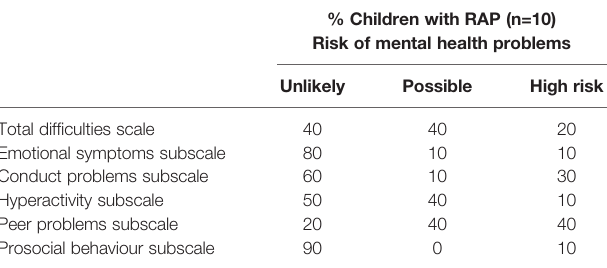
TABLE 1 | Risk of mental health problems as screened by SDQ total scores and each subscale scores in children with RAP. % Children with RAP (n=10) Risk of mental health